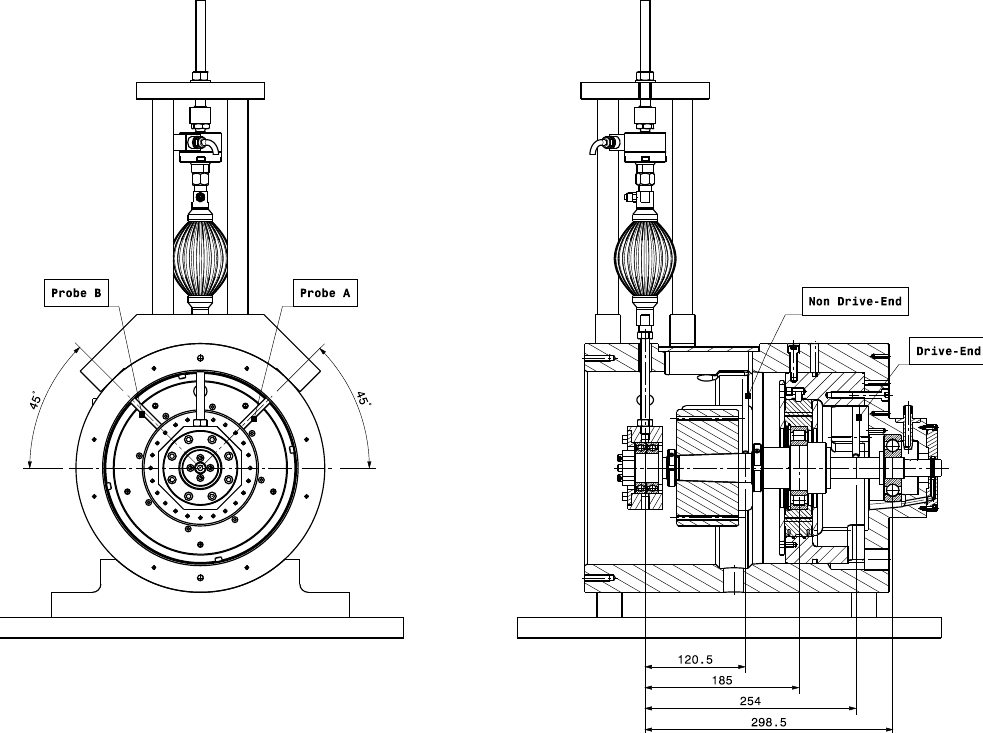
Figure 9. Locations of the proximity sensors (dimensions in